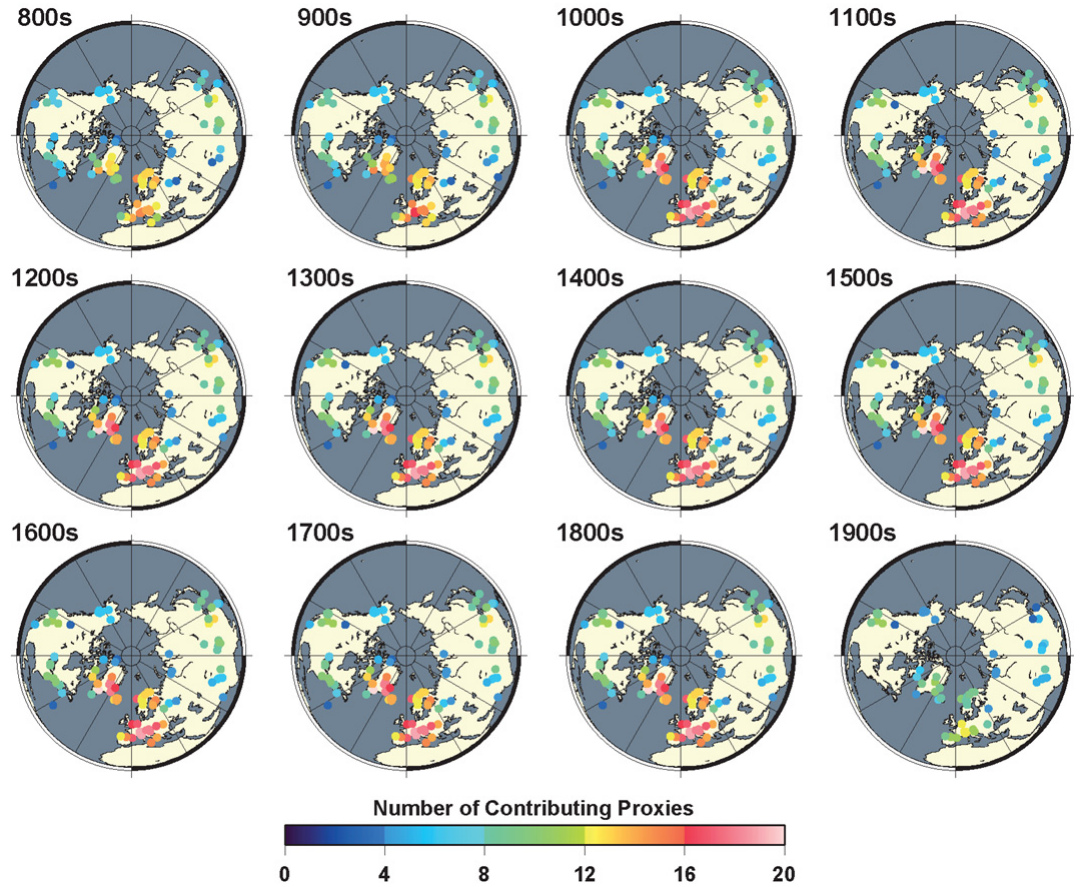
Fig. A6. Number of contributing proxies considered in each proxy-centred anisotropic weighted mean calculation where there are 3 or more neighbouring proxies found in the search